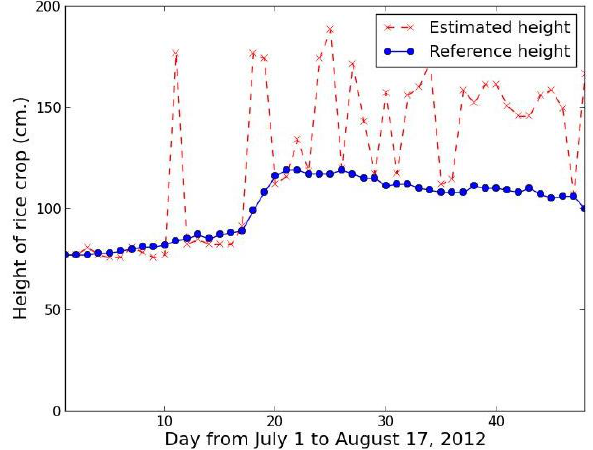
Figure 23. Rice crop height series from 1 July to 17 August 2012 using proposed method with red band